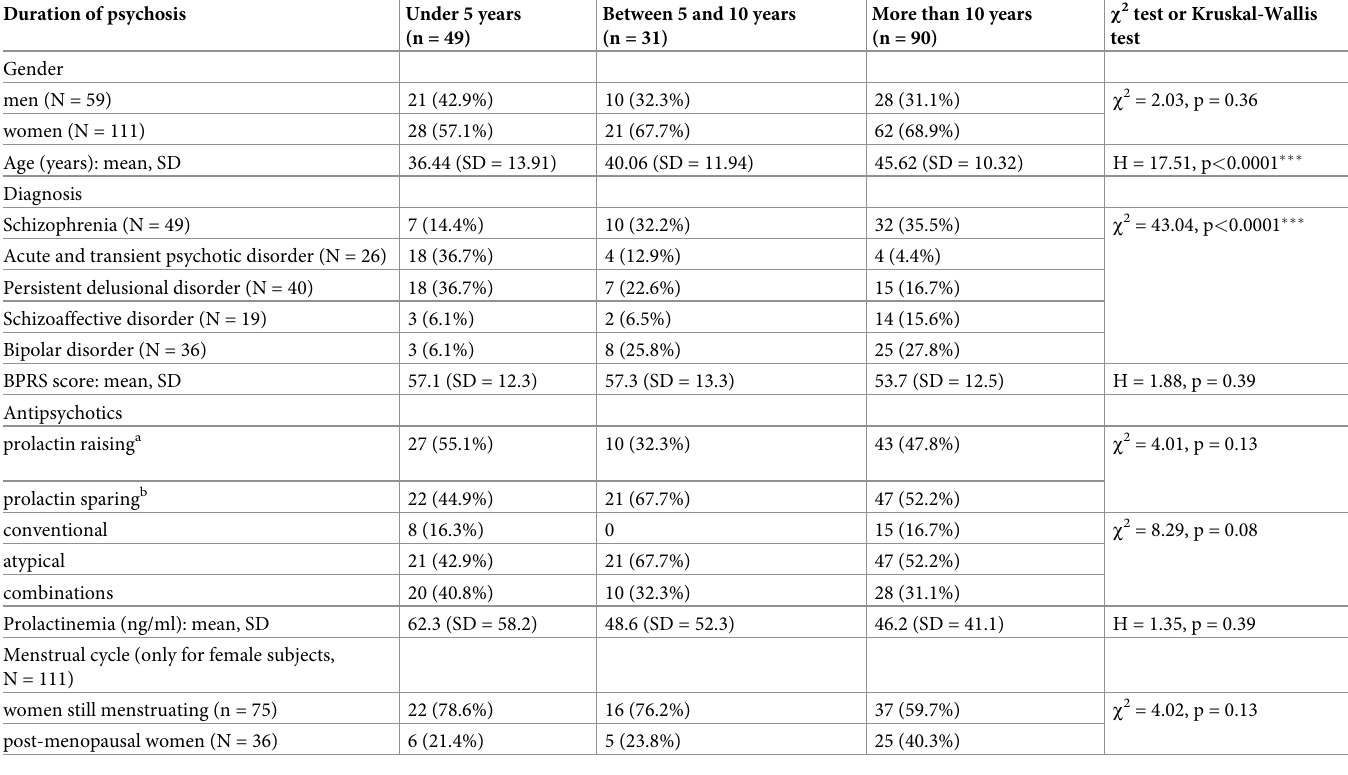
Table 5. Sample characteristics according to the duration of the